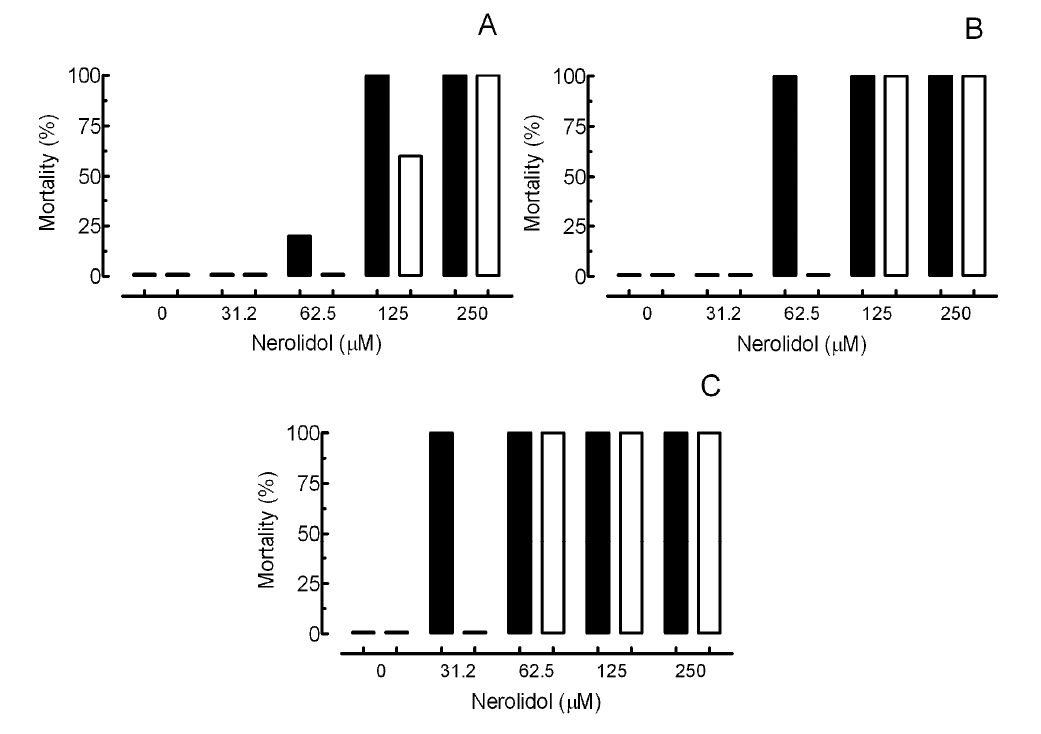
Figure 2. In vitro effect of nerolidol on the survival of Schistosoma mansoni after 24 h ( A ), 48 h ( B ) and 120 h ( C ) of treatment. Pairs of adult worms, males (closed bars) and females (open bars), were incubated in 24-well culture plates containing RPMI 1640 medium and treated with nerolidol at different concentrations. Mortality data are presented from ten worm couples and values correspond to the sum of the adult schistosomes obtained from three separate experiments performed in triplicate ( n = 2) and quadruplicate ( n = 1).